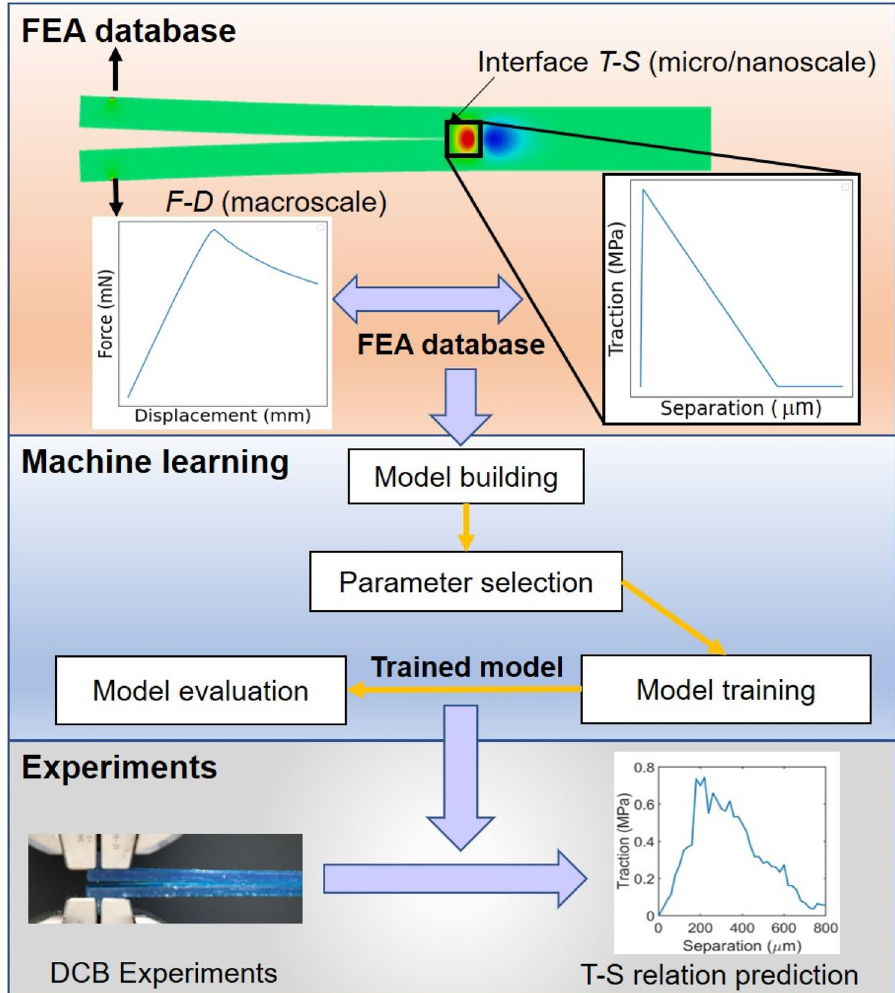
Figure 1. An overview schematic of the development of a data-driven method for establishing interfacial properties. The method includes FEA database generation, multi-output ML models training, and experimental